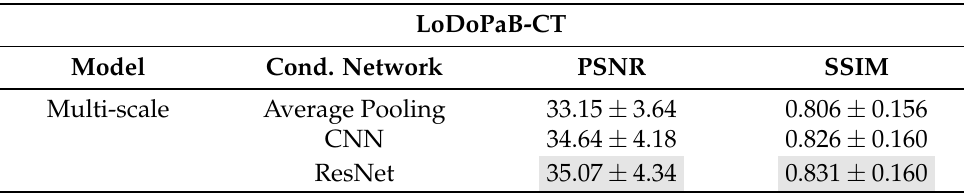
Table 2. Influence of the type of conditioning network for the multi-scale cINN. The mean and standard deviation of the PSNR and SSIM were evaluated on the full LoDoPaB test set using 1000 samples for the cond. mean.